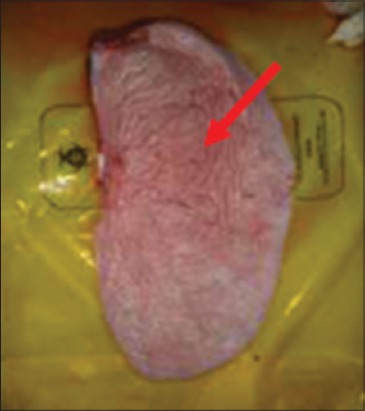
Congested and hemorrhagic spleen.